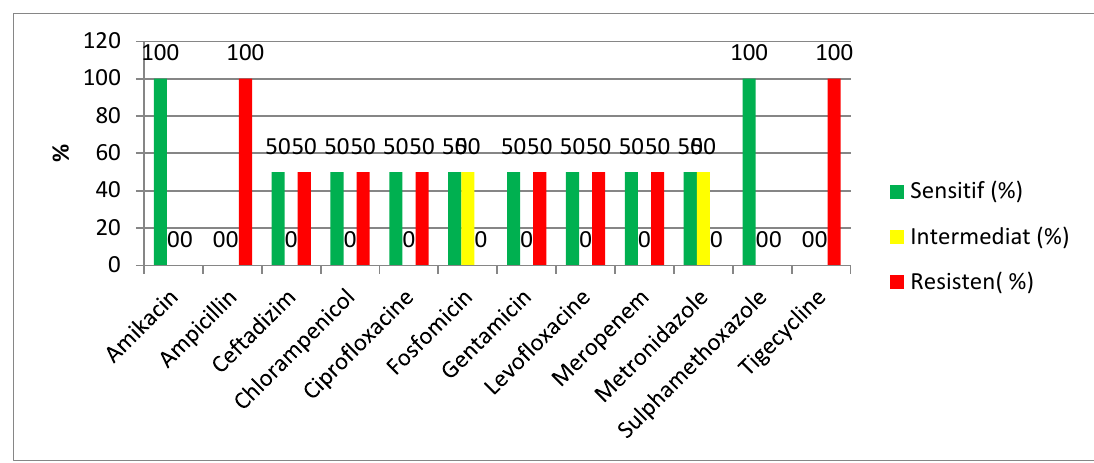
Fig. 4. Antibiotic sensitivity pattern of pseudomonas sp